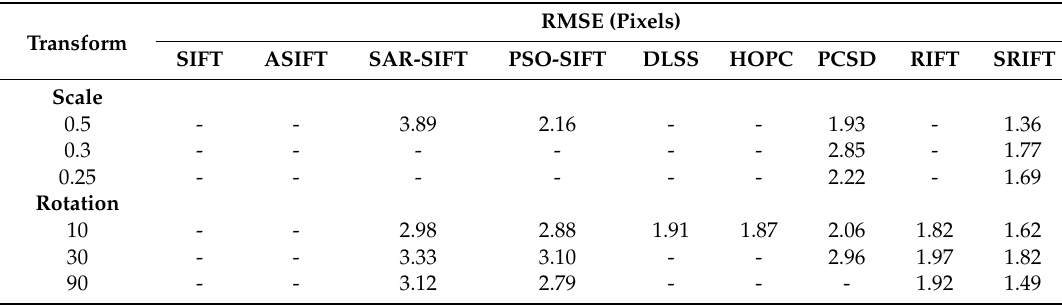
Table 1. Root-mean-square error (RMSE) comparison for simulated dataset 1 (GF-3 SAR image and GF-2 optical image).